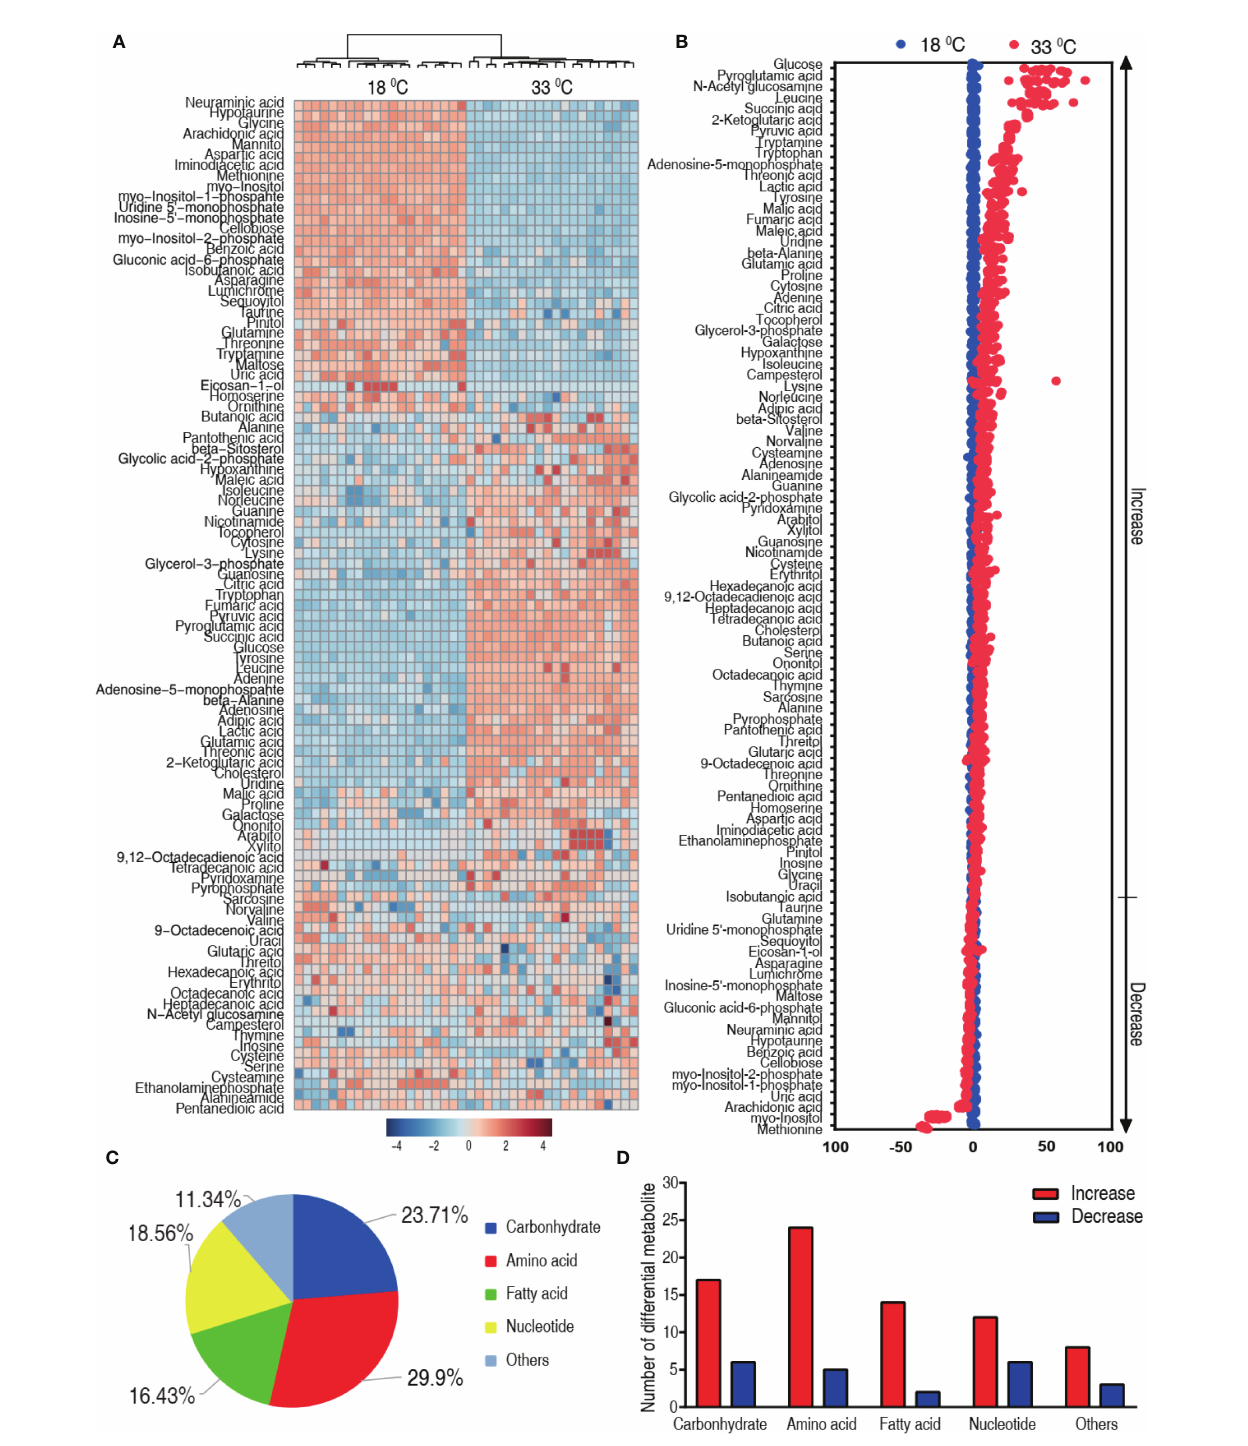
FIGURE 3 | Differential metabolic pro fi les of tilapias cultured at different temperatures. (A) Heat map showing 97 differential metabolites. Red and blue indicate increase and decrease of metabolites relative to the median metabolite level, respectively (see color scale). (B) Z-score plot of differential metabolites based on the 18°C group. Each point represents one metabolite in one technical repeat and colored by sample types. (C) The different metabolites were classi fi ed into fi ve categories, carbohydrate (23.71%), amino acid (29.9%), nucleotide (16.43%), fatty acid (18.56%), and others (11.34%). (D) Number of increased and decreased metabolites in these categories (C) , 17 and 6 (carbohydrate), 24 and 5 (amino acid), 14 and 2 (nucleotide), 12 and 6 (fatty acid), and 8 and 3 (others),